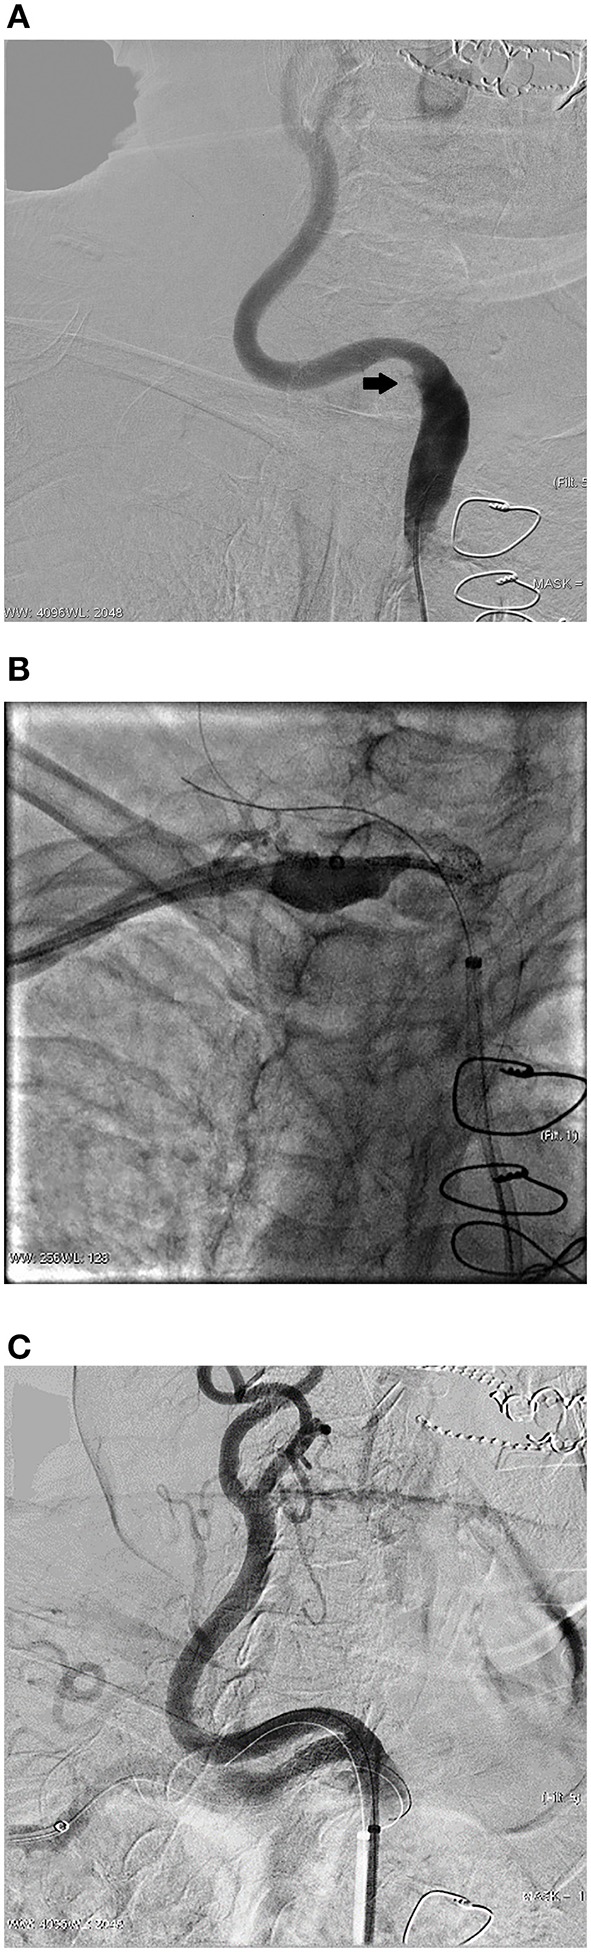
A representative case of successful retrograde recanalization. This was an 84 years old female patient who presented with vertigo for 1 year. (A) Angiography shows occlusion of the right subclavian artery ostium. (B) After failed antegrade recanalization, we attempted retrograde recanalization via the brachial artery. An emboli protection device was placed in the right internal carotid artery. Angiography was performed before deploying a balloon expandable stent to confirm the accurate location. (C) Angiography shows the perfect position of the stent, which completely covered the lesion but did not affect the blood flow of the right carotid artery.